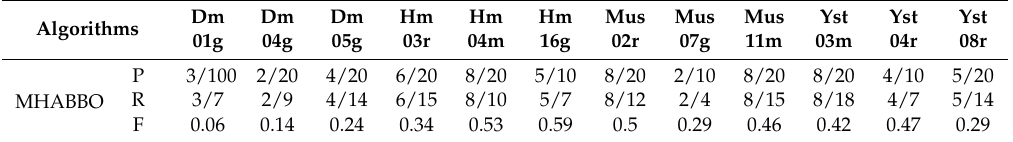
Table 9. Average results (precisions (P), recalls (R) and F-scores (F)) of MHABBO on the twelve datasets.